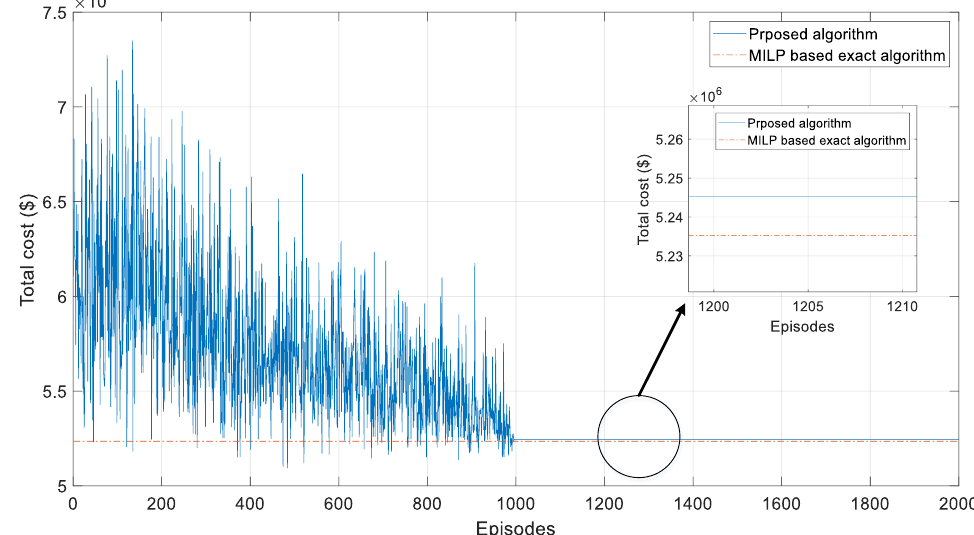
Figure 13. Cost comparison of exact and proposed algorithms in a static traffic